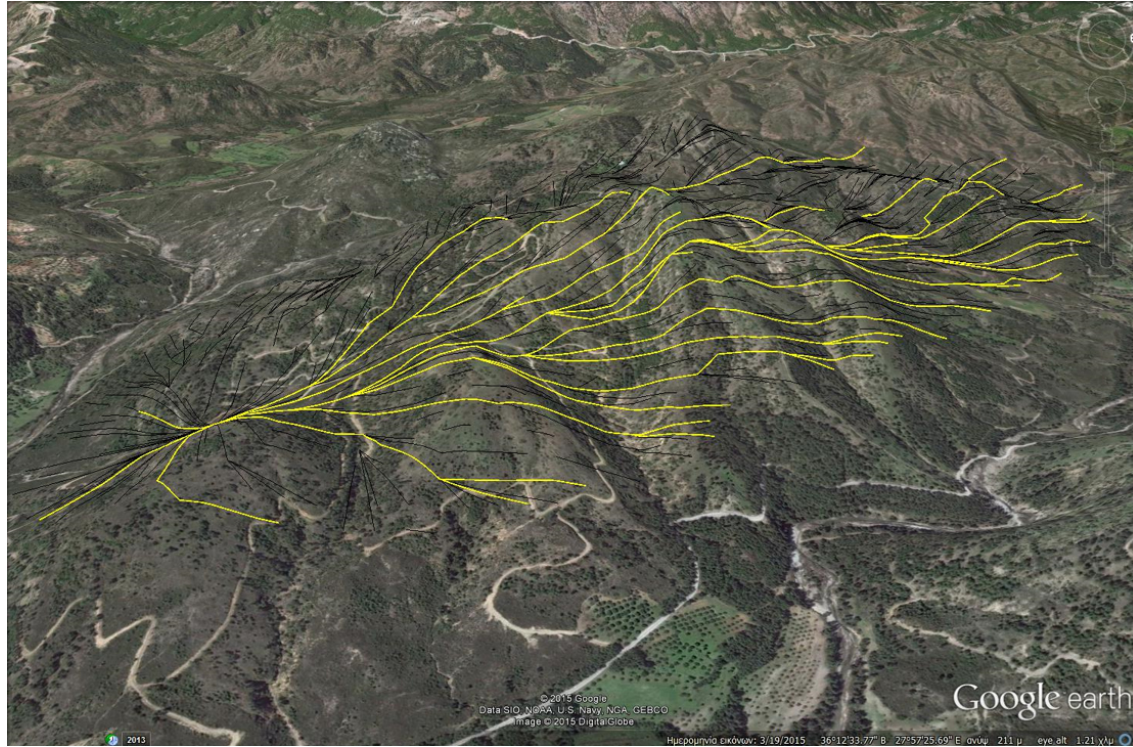
Figure 12. Visualization of travel paths from a wildfire simulation through the AEGIS platform over Google